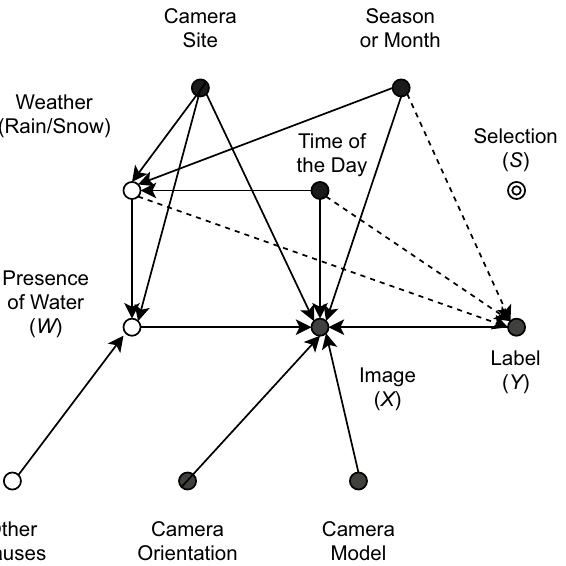
Figure 2. Causal model for the prediction of wet road conditions. Hidden variables are depicted with empty